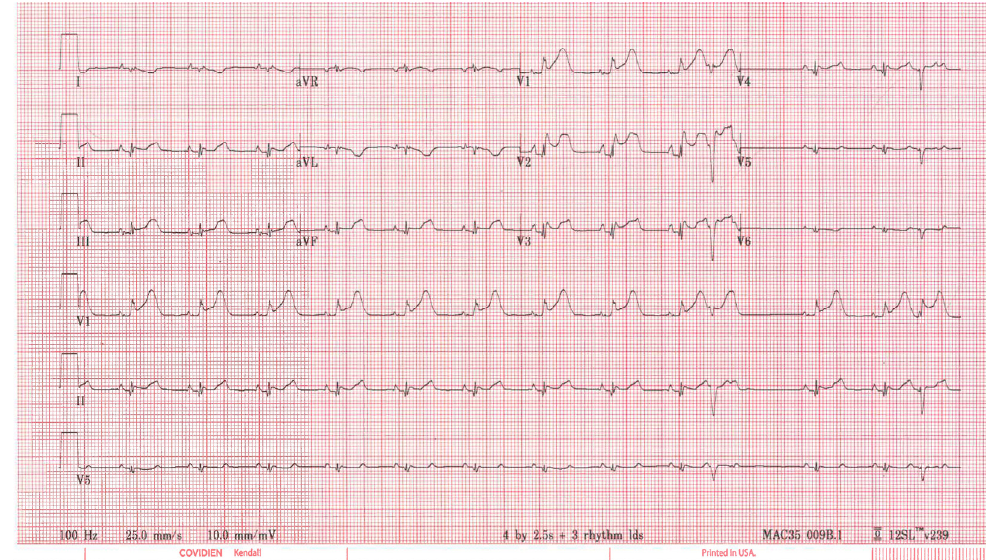
Figure 2. Representative 12-lead ECG recording at 5 min after LAD occlusion.